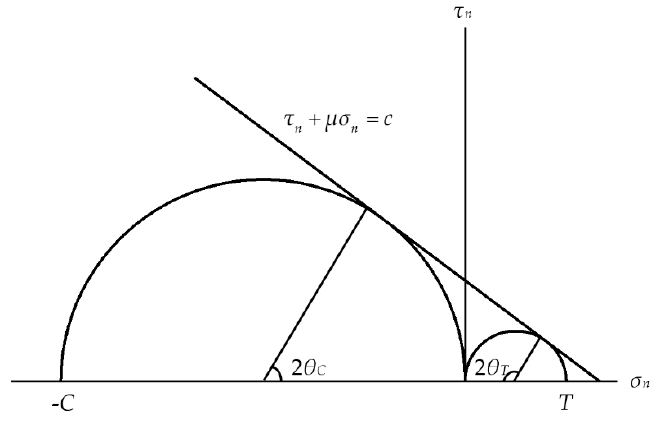
Figure 2. Coulomb’s linear envelope.